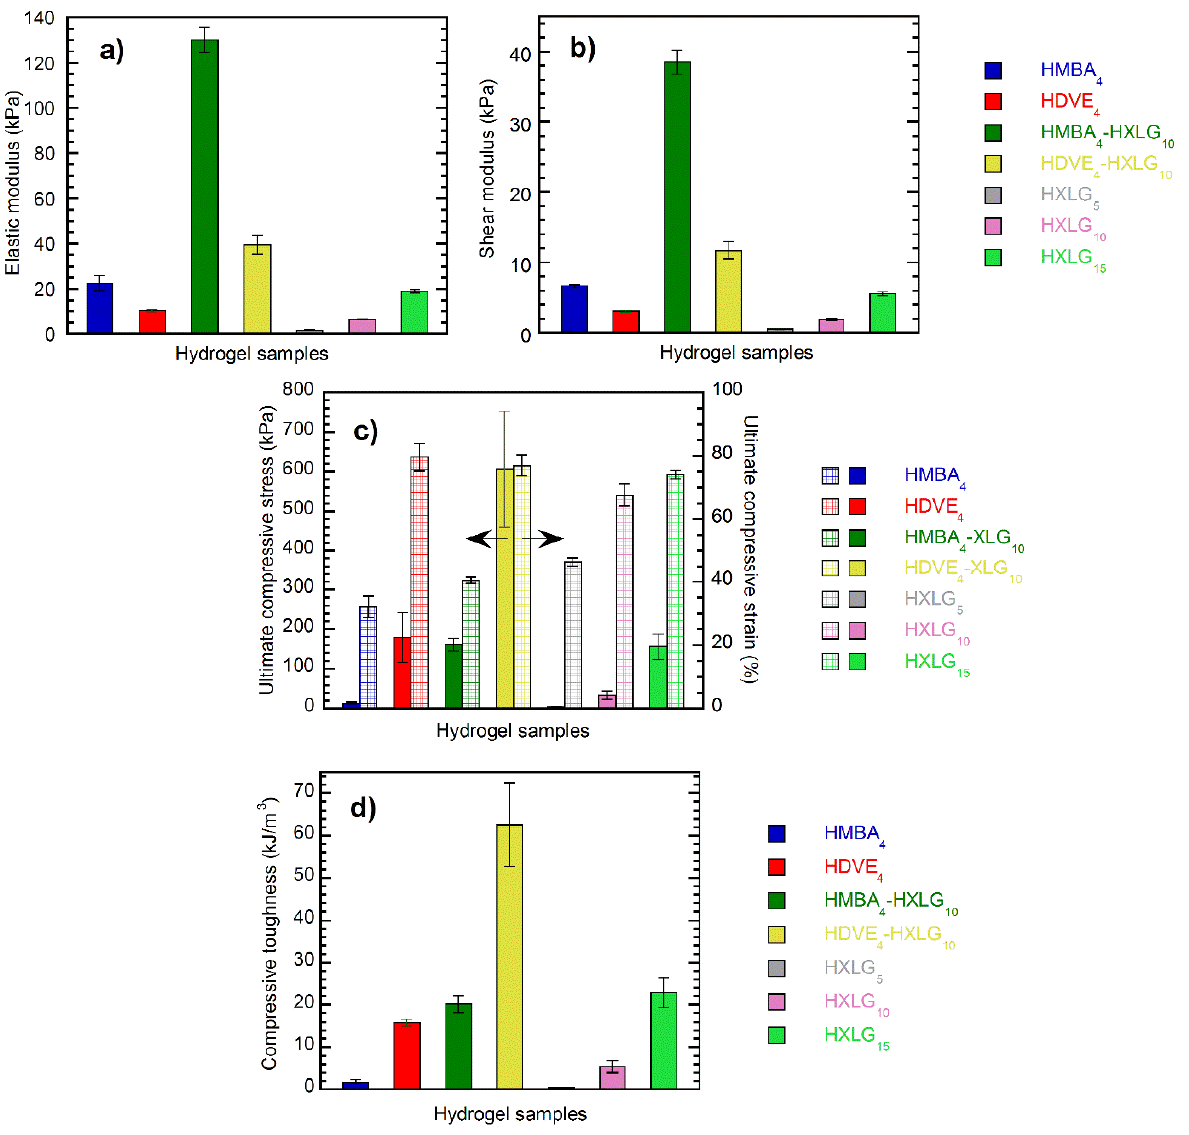
Figure 12. Compressive mechanical properties of the hydrogels synthesized: ( a ) elastic modulus; ( b ) shear modulus; ( c ) ultimate compressive stress and strain; ( d ) compressive toughness.